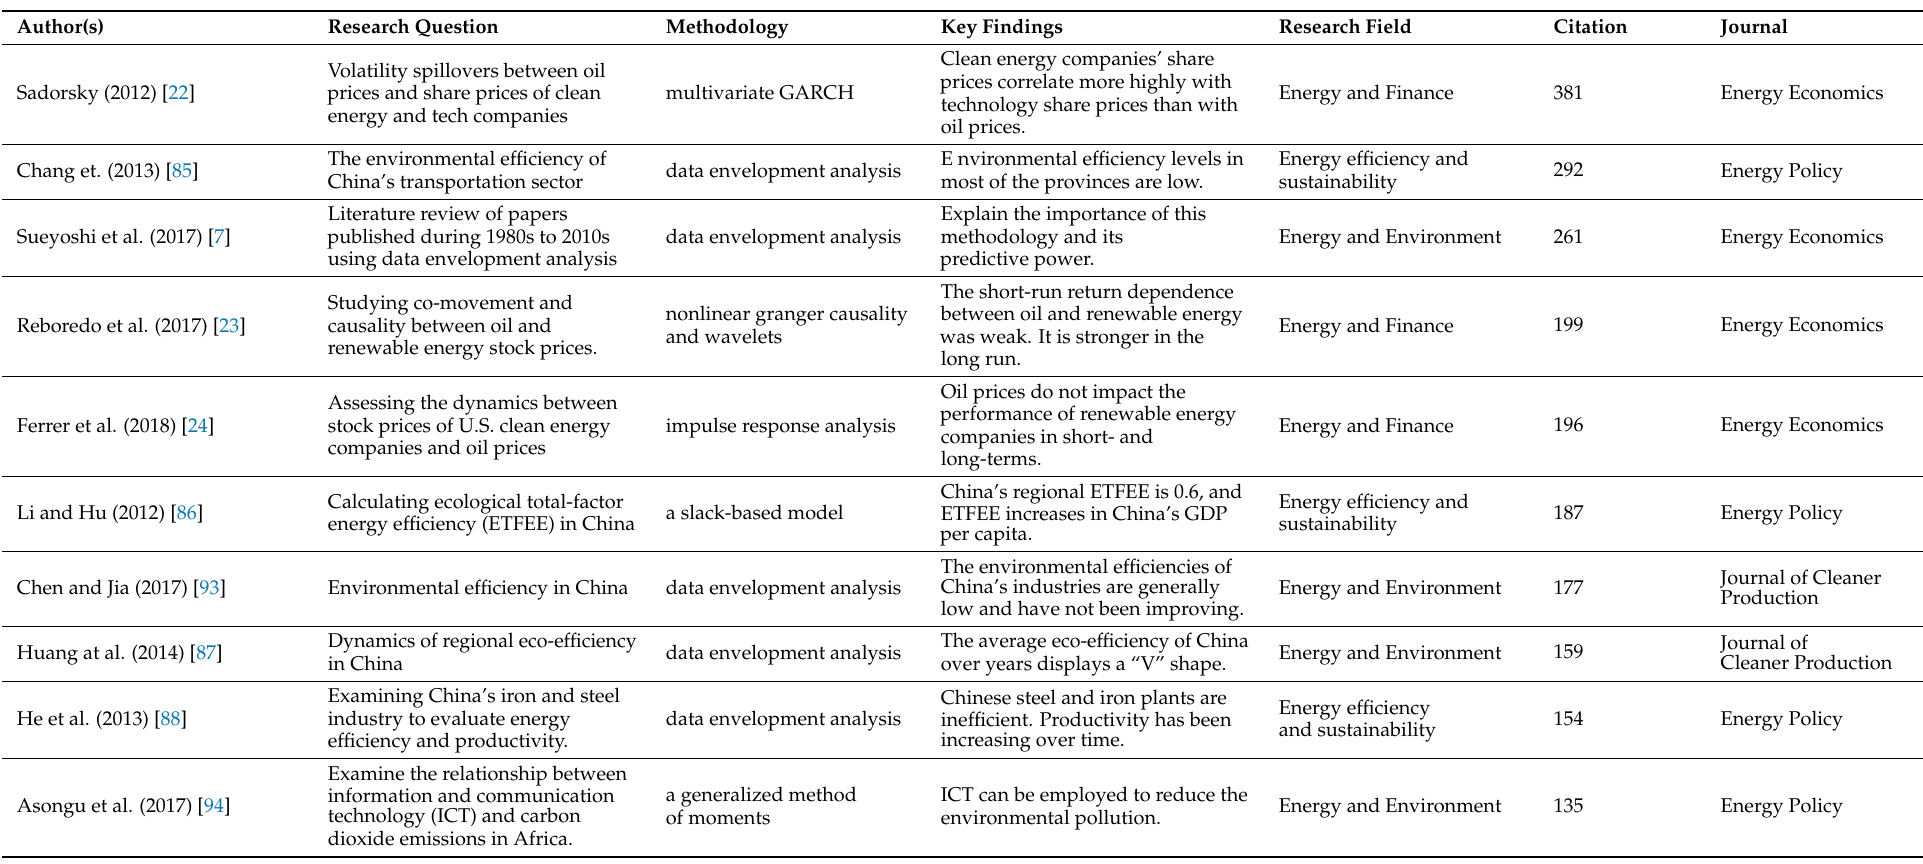
Table 5. Ten most cited papers related to economic aspects of the energy